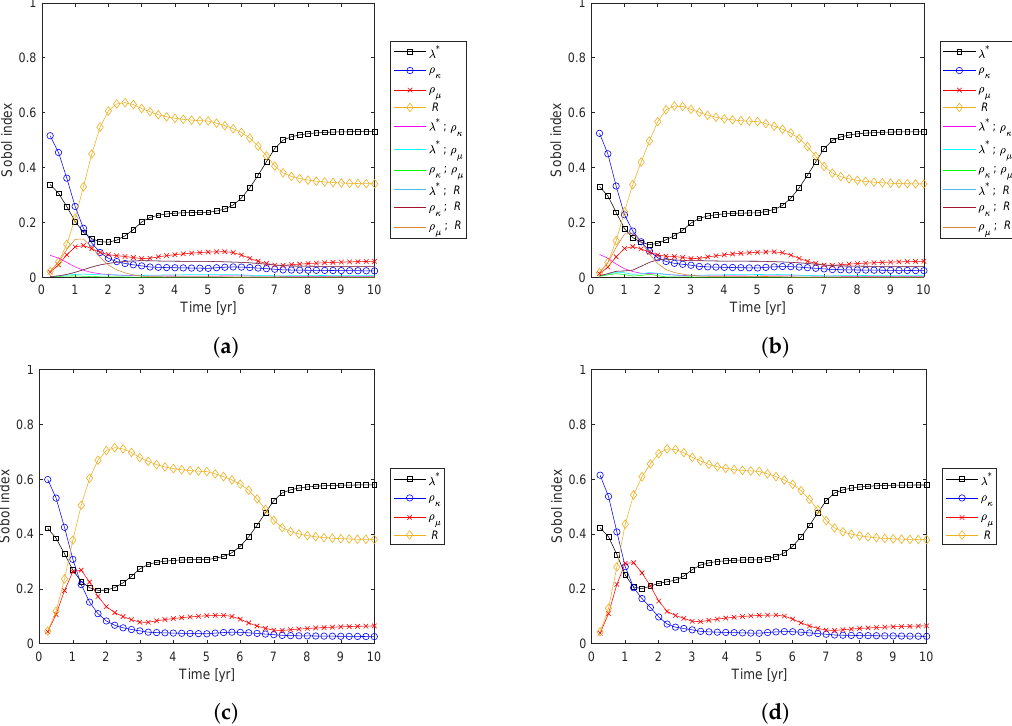
Figure 3. Sobol’ indices versus simulated time. Profiles with markers are used for the single parameters, while continuous profiles are used for the combinations of parameters. ( a ) Case with n = 4 parameters and gPCE degree N = 2. ( b ) Case with n = 4 parameters and gPCE degree N = 3 with a sparse grid. ( c ) The same as ( a ) considering the total effect. ( d ) The same as ( b ) considering the total